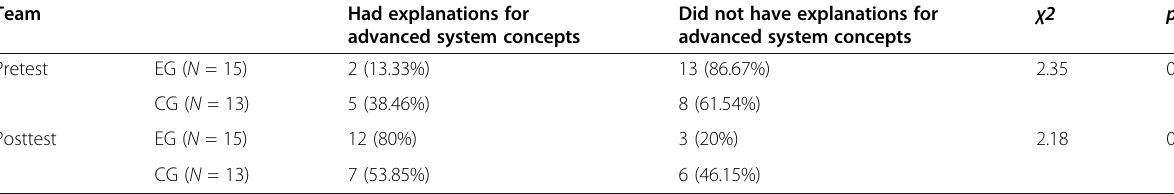
Table 6 Preservice technology teachers ’ performance: explanations of advanced system concepts (overall) Team Had explanations for Did not have explanations for advanced system concepts advanced system concepts